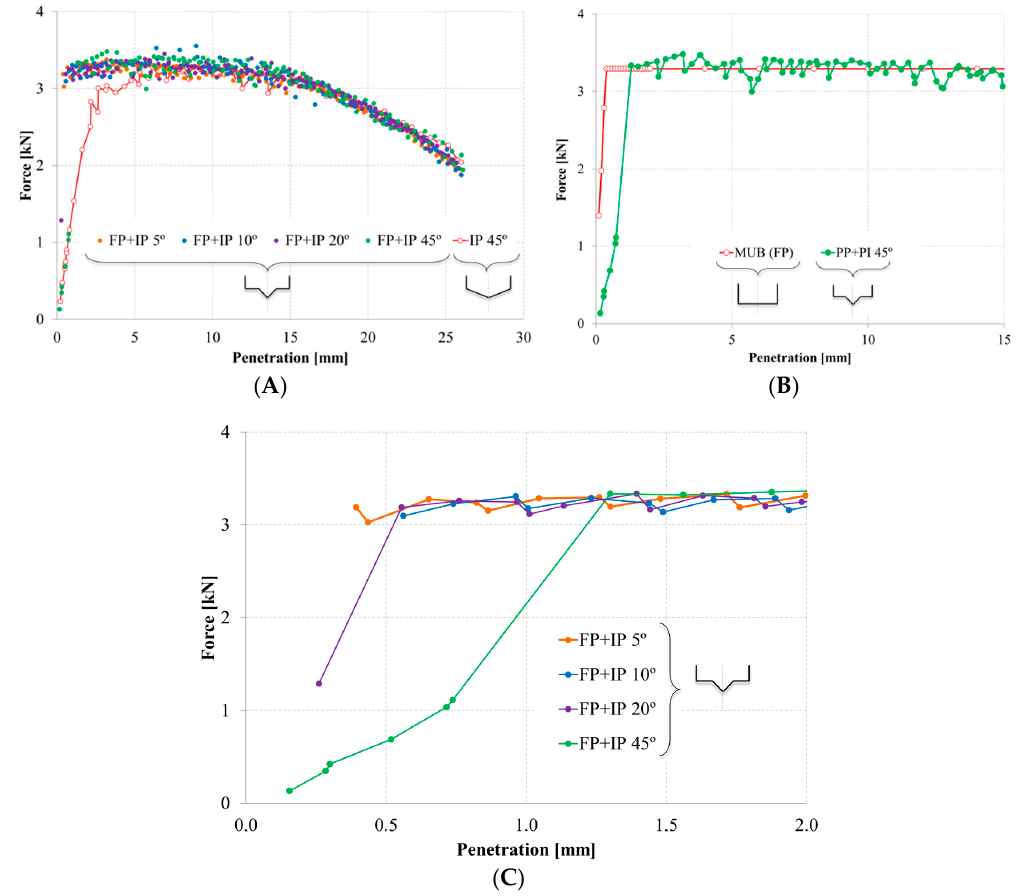
Figure 9. FP + IP simulation. Results obtained for different α compared with result from IP simulation ( A ); FP + IP and MUB for FP comparison ( B ) and first deformation stage details ( C ).